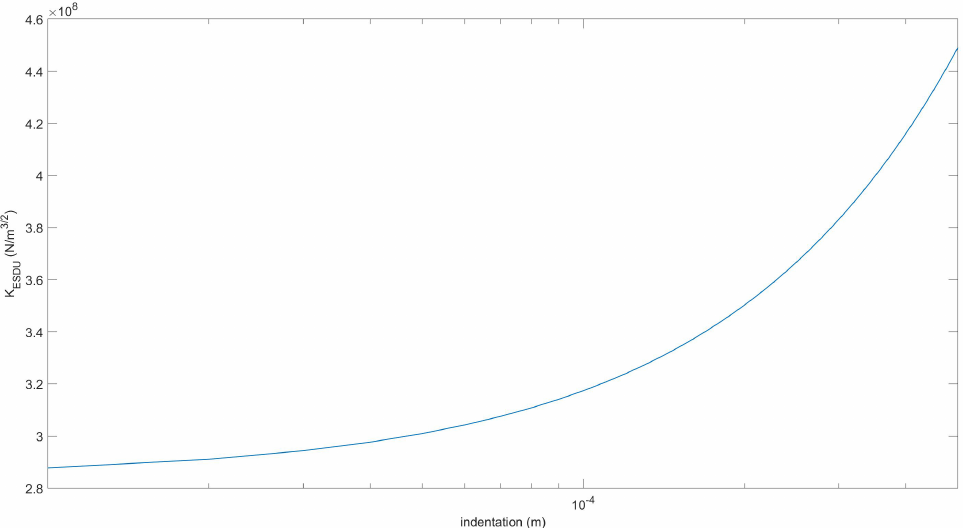
Figure 5. Generalized stiffness evaluated using the Lankarani–Nikravesh/ESDU impact model